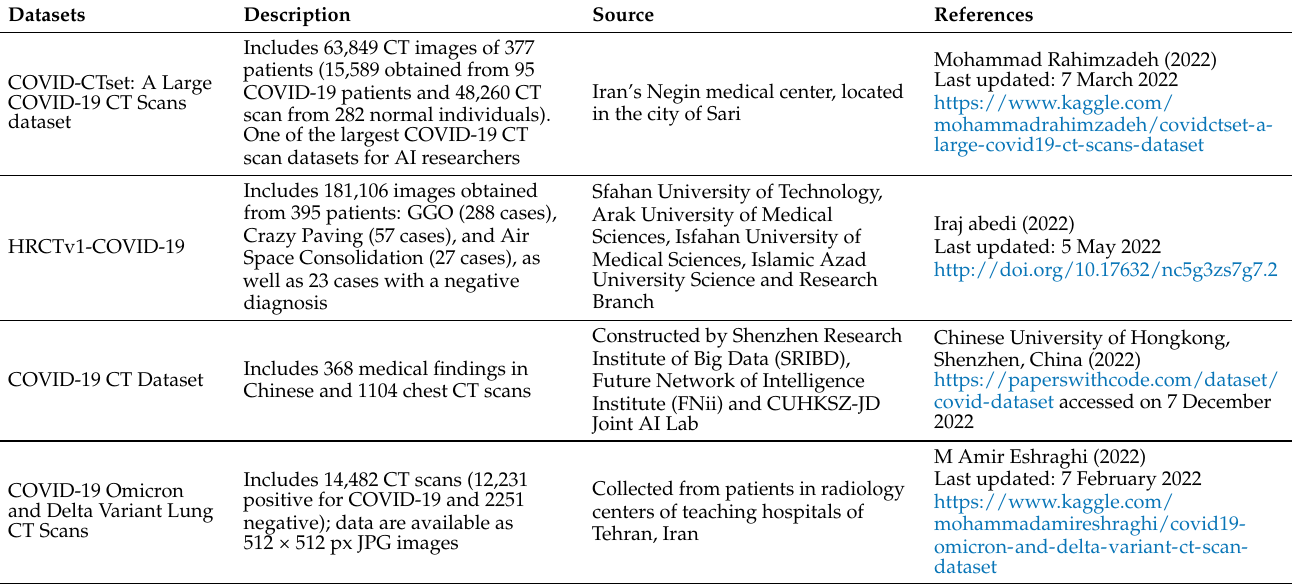
Table 2. COVID-19 CT Image